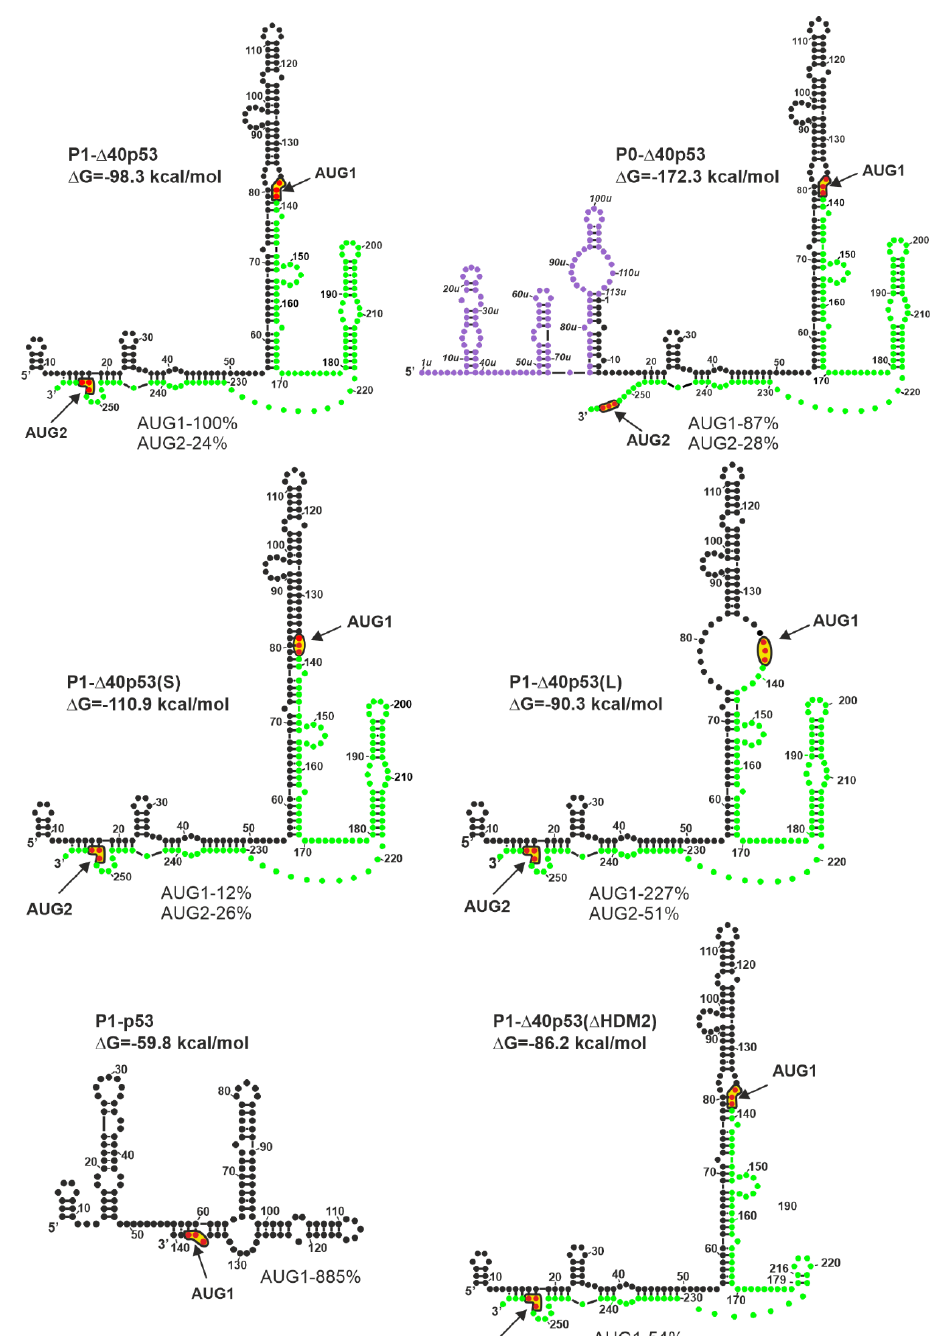
Figure 3. Different length and structure of the 5 ′ -terminal region of p53 mRNA influence the translation efficiency of p53 and Δ 40p53 (modified from [27] ). Colors denote parts of the 5′ -terminal region of model p53 mRNAs: Violet – the region between P0 and P1 transcription promoters; black – the 5′ untranslated region downstream P1 promoter; green– p53 open reading frame (ORF). The predicted ΔG value (kcal/mol) for each 5′UTR is ind icated. The data given as percentage illustrate approximate values of maximal translation efficiency for each construct from AUG1 and/or AUG2 normalized to the value obtained for translation of model P1-40p53 mRNA from the AUG1 initiation codon.